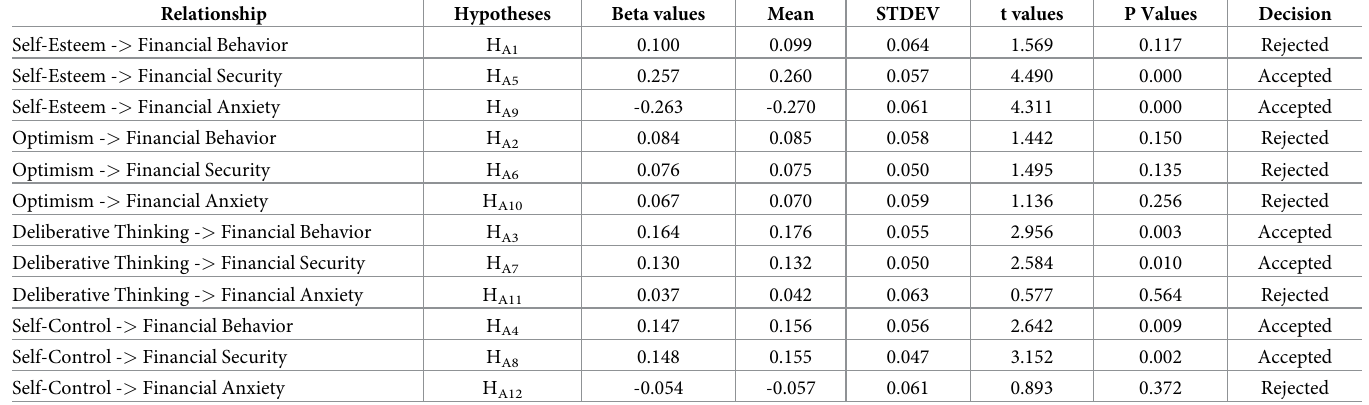
Table 4. Path coefficients of